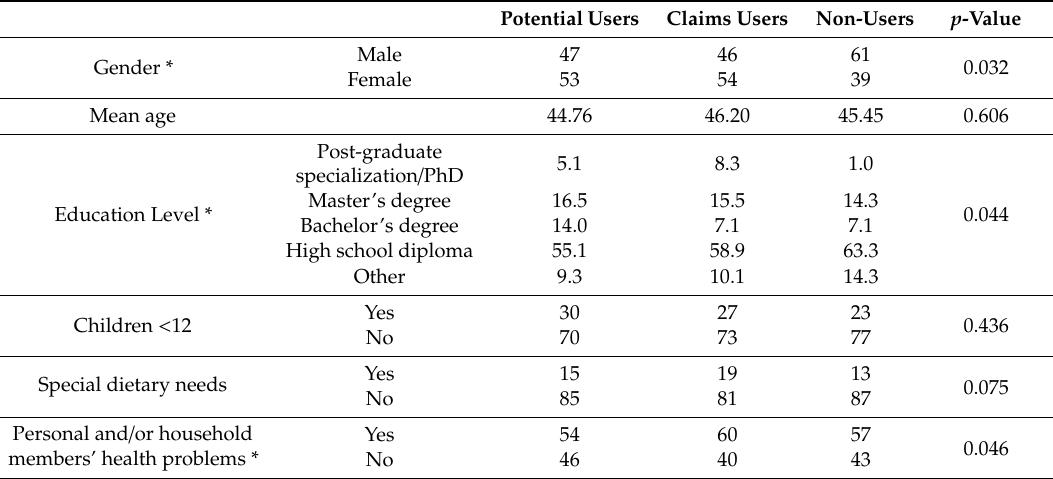
Table 5. Cluster profiles based on